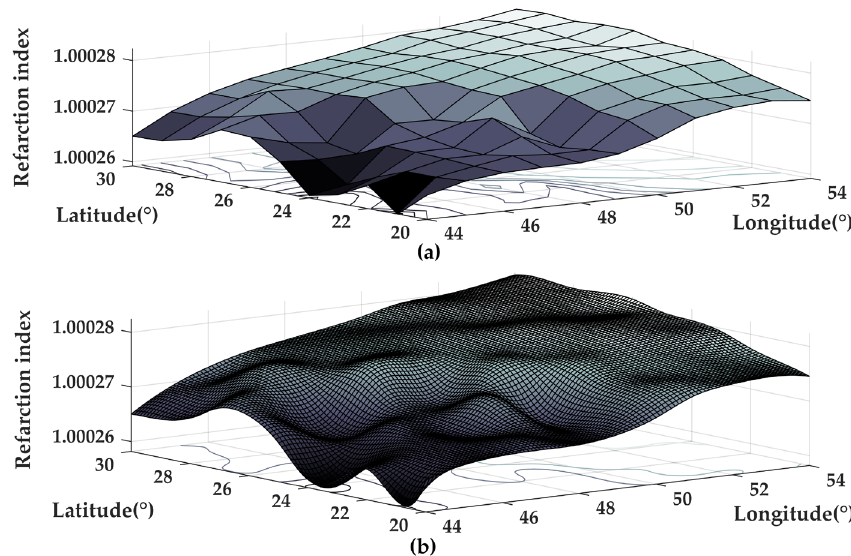
Figure 2. Atmospheric refraction index with a pressure of 1000 mb at noon on 1 March 2022. ( a ) The atmospheric refraction index of the NCEP GDAS/FNL 0.25 Degree Global Tropospheric Analyses and Forecast Grids (083.3). ( b ) The atmospheric refraction index after cubic spline interpolation.